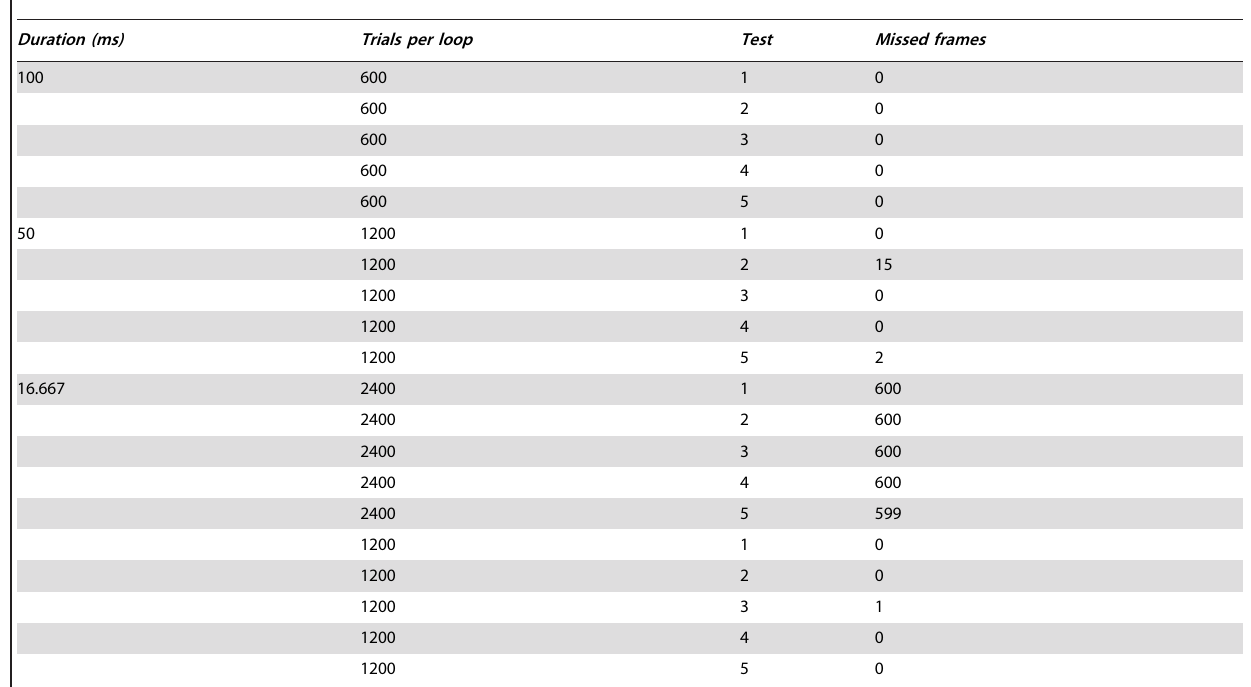
Table 5. PsychoPy 1.80 timing tests on MacBook Pro Mid 2009 under Windows 7 64-bit